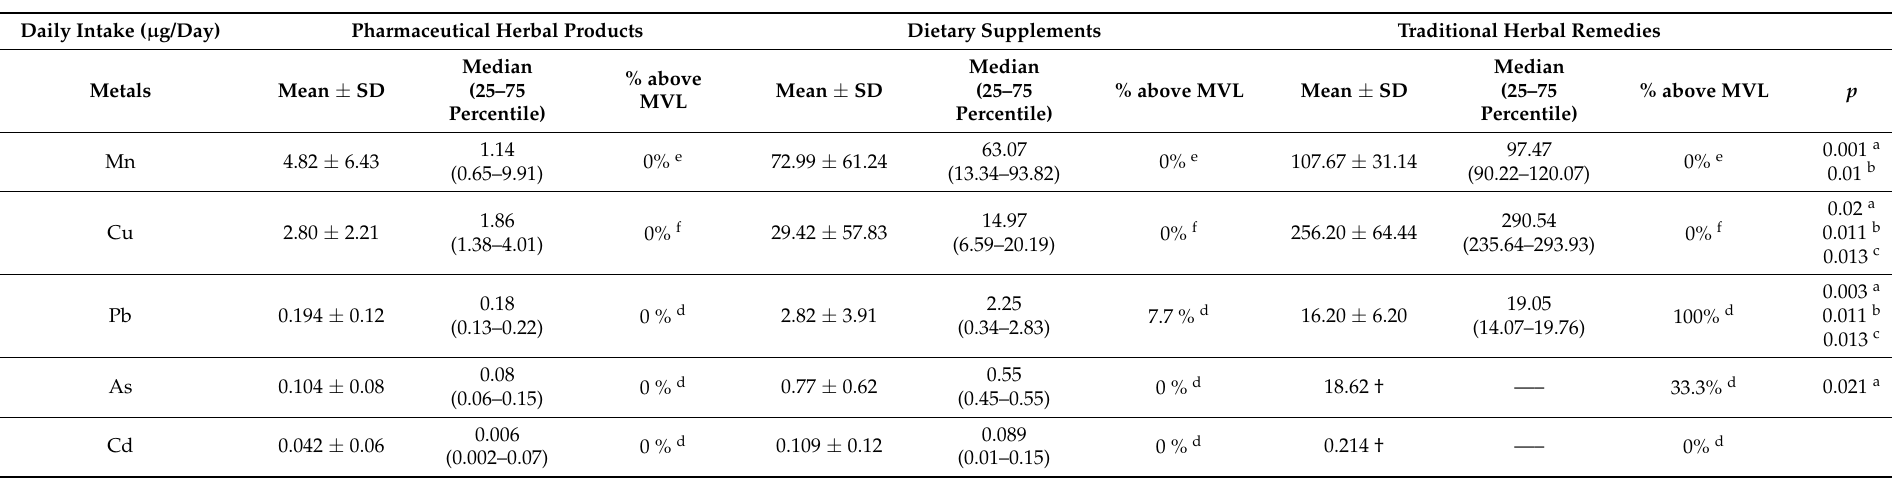
Table 3. Differences between groups with respect to metals